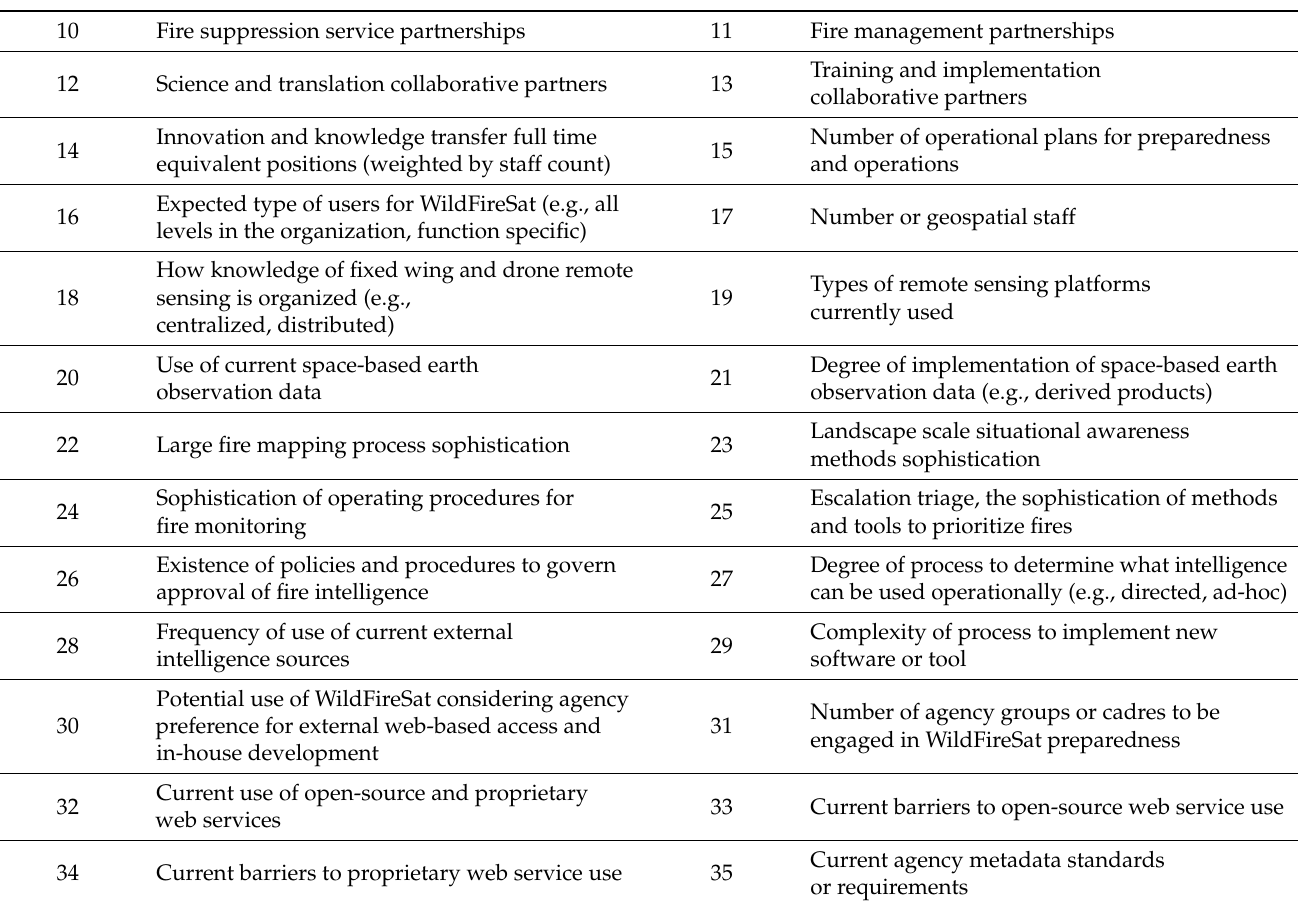
Table 2. Indicators of readiness from survey